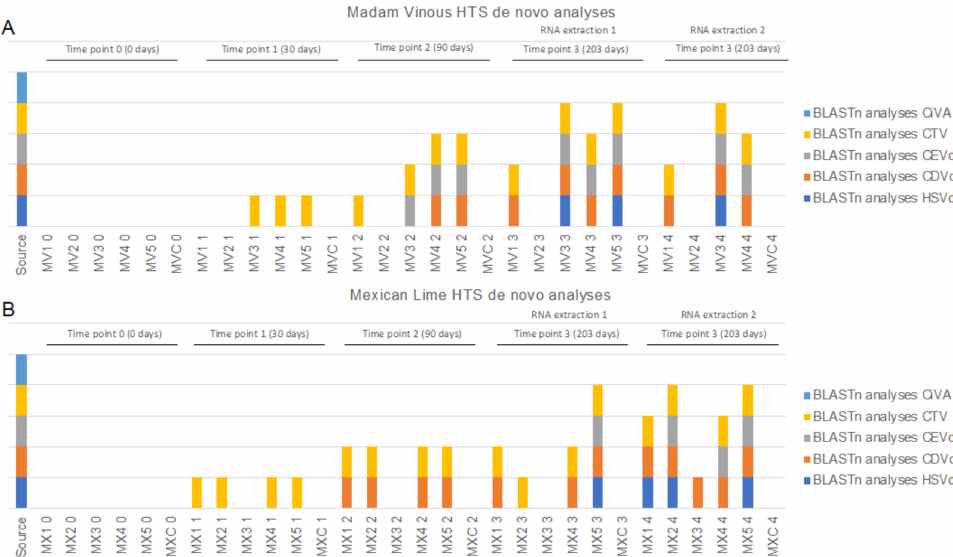
Figure 3. Stacked column chart displaying the virome profile of Madam Vinous ( A ) and Mexican Lime ( B ) plants at different time points constructed with BLASTn results of de novo assembled contigs of HTS reads. Each column represents a plant (MV1–5 or MX1–5) from which RNA was extracted 5 times (0–4). Extractions 3 and 4 were extracted both on 203 days post inoculation, but with different RNA extraction methods (RNA extraction 1: CTAB with LiCl precipitation; RNA extraction 2: CTAB extraction with ethanol precipitation). Samples MVC and MXC represent the healthy controls. Sample MV5 (extraction 4) was not evaluated with HTS. (CTV: citrus tristeza virus, Ci-VA: citrus virus A; HSVd: hop stunt viroid; CDVd: citrus dwarfing viroid; CEVd: